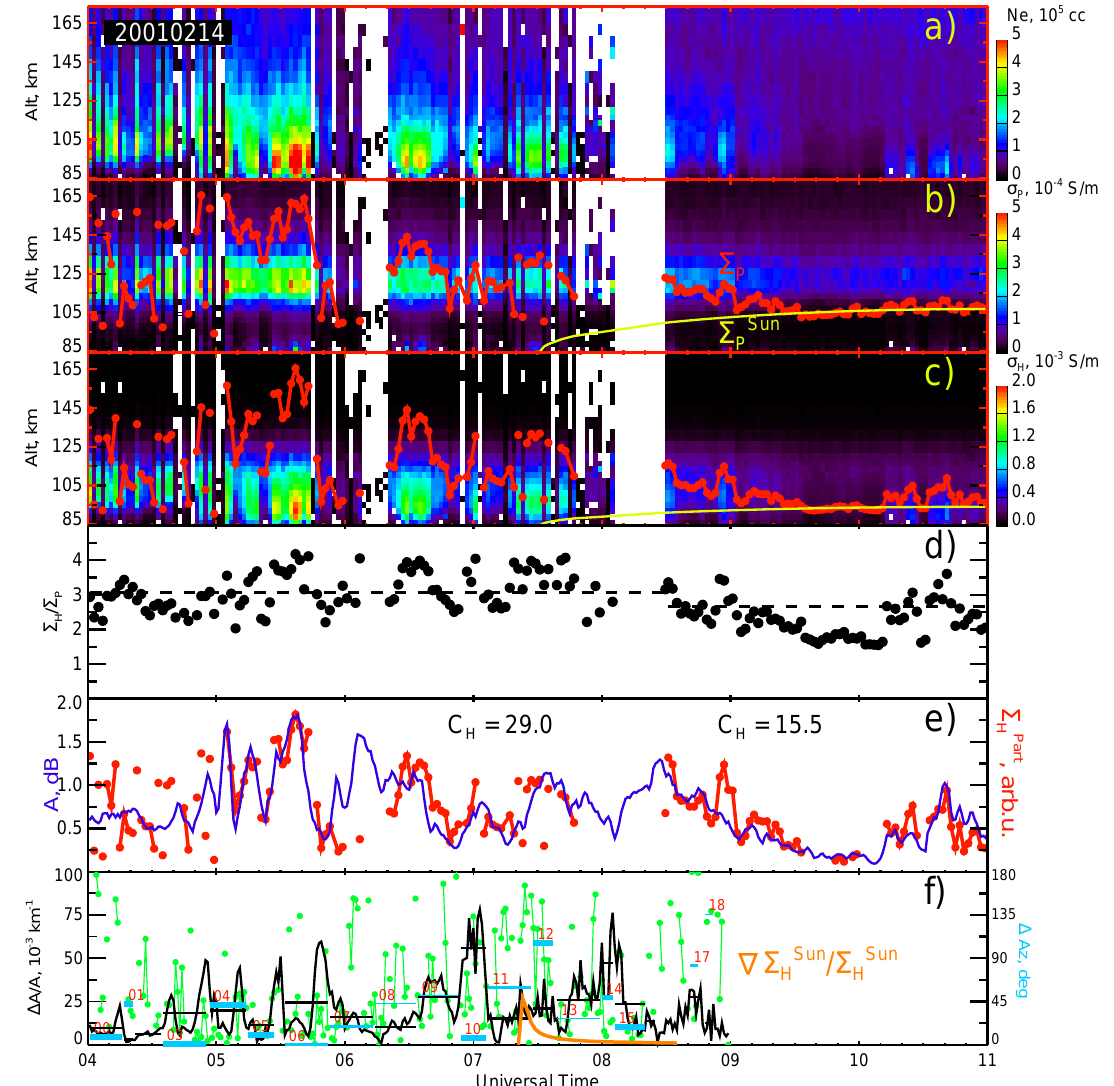
Fig. 7. Ionospheric conductances from the EISCAT measurements on 14 February 2001, 04:00–11:00 UT. First three panels show (a) the electron density N e , (b) Pedersen conductivity σ P , and (c) Hall conductivity σ H from 84.4 to 173.5km. The colour bars are shown on the right of each panel. Also shown in panels (b) and (c) by red dots and lines are the Pedersen ( 6 P ) and Hall ( 6 H ) conductances, respectively, and the model conductances ( 6 Sun and 6 Sun ) due to the sunlight (Robinson and Vondrak, 1984). Panel (d) shows the ratio P H α = 6 H /6 P with the average night- and daytime ratios (3.06 and 2.66, respectively) shown by dashed lines. Panel (e) shows the absorption intensity at IRIS beam 16 (blue), together with the normalized Hall conductance due to the particle precipitation 6 Part (red). The scaling H /A is different for night- and daytime conditions, as indicated on the top of panel (e). The red dots in panel (e) coefficient C H = 6 Part H are connected only if the difference between neighbour points is less than 0.5dB. The bottom panel (f) shows by a black line the relative gradient of absorption 1A/A at the IRIS FoV centre (IRIS beam 25) and by blue lines the difference in drift azimuths 1 Az = | Az Magn − Az Rio | as determined from absorption images and magnetometer records from Fig. 2e. The relative gradient of the conductance due to /6 Sun the sunlight ∇ 6 Sun is shown by the orange line. The black horizontal lines indicate the average relative absorption gradients (for the H H patch duration). The instantaneous (1-min resolution) difference in azimuths is shown by green dots (connected if the difference between neighbour points < 45 ◦